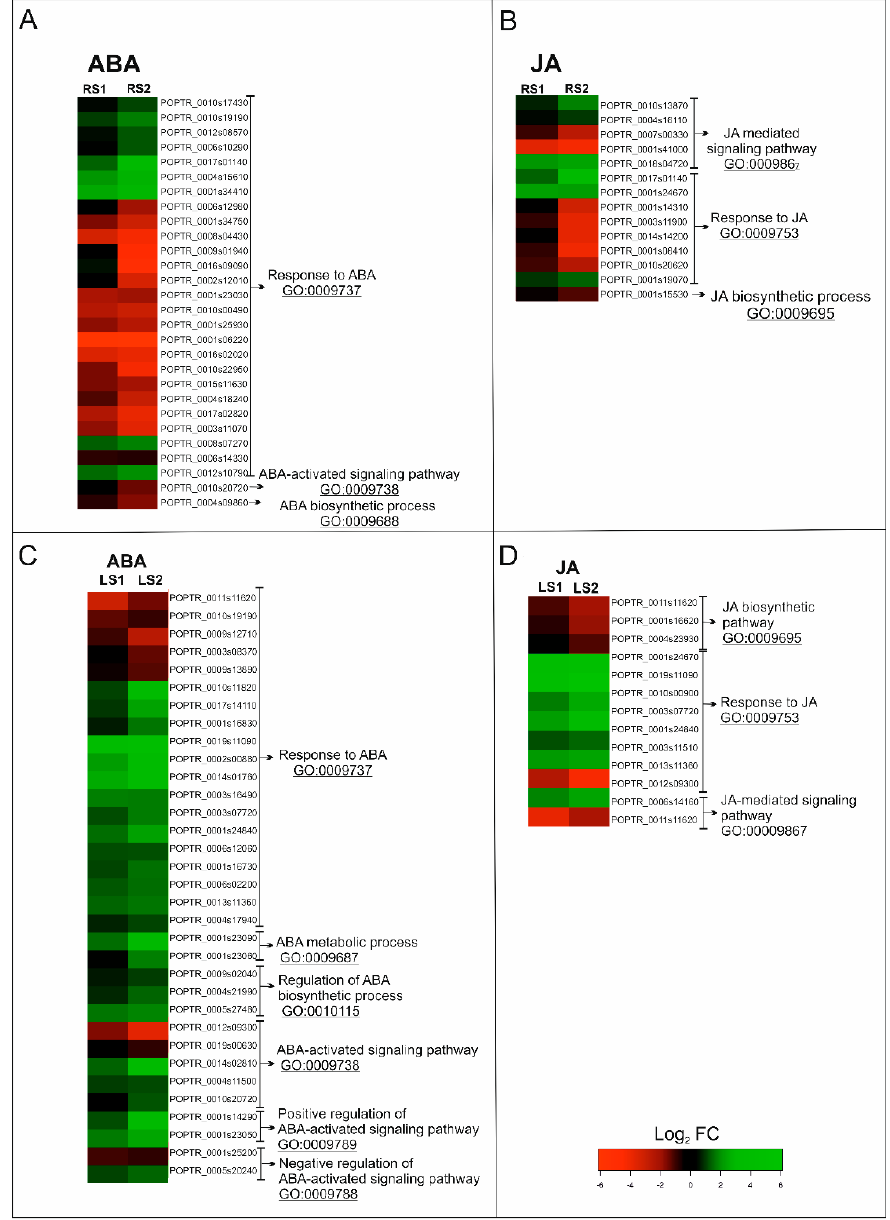
Figure 4. Changes in the expression of phytohormone-related genes in roots ( A , B ) and leaves ( C , D ) during senescence. ( A , C ) Heatmap illustrating the expression profiles of ABA-related genes. ( B , D ) Heatmaps illustrating the expression profiles of JA-related genes. Abbreviations: ABA, abscisic acid; JA, jasmonic acid; FC, fold change.